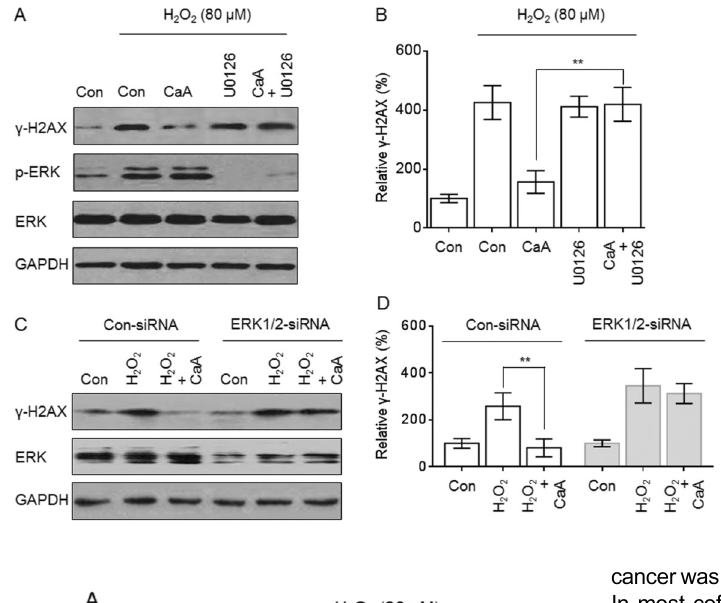
Figure 5. Extracellular signal-regulated kinase (ERK) inhibition blocked the caffeic acid (CaA)- induced reduction in double-strand breads (DSBs) in human L-02 cells. A , B , After pretreat- ment with 0 or 10 m M CaA in the presence or absence of U0126 (10 m M) for 24 h, they were exposed to 80 m M H 2 O 2 for 24 h. A , Western blots and B , relative c -H2AX protein levels. **P , 0.01 compared with L-02 cells treated with CaA plus H 2 O 2 . C , D , After L-02 cells were transfected with 20 nM ERK1-siRNA plus ERK2- siRNA for 12 h, they were treated with 0 or 10 m M